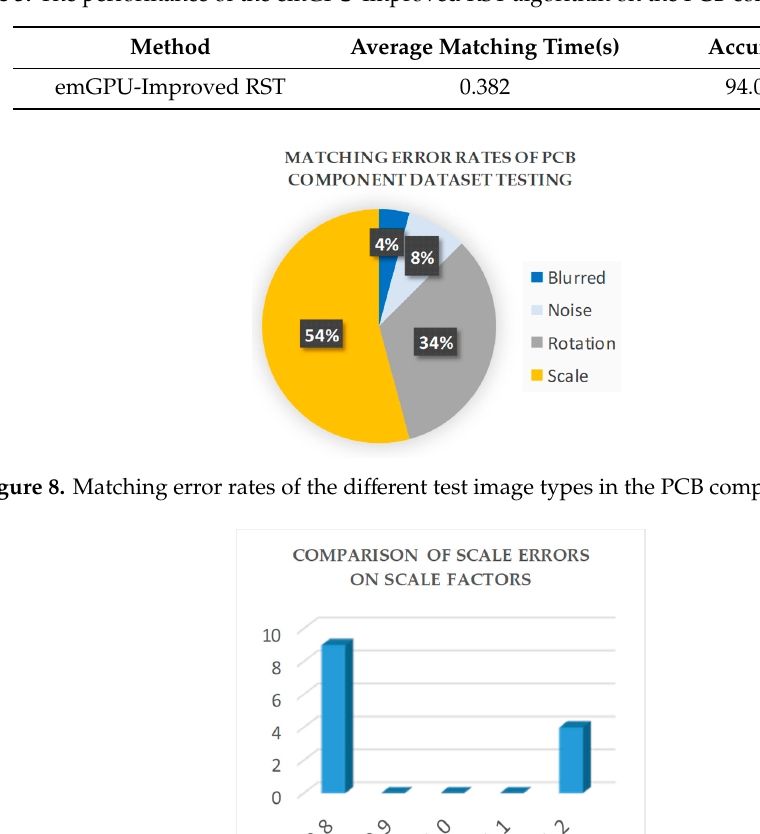
Table 3. The performance of the emGPU-Improved RST algorithm on the PCB component dataset.